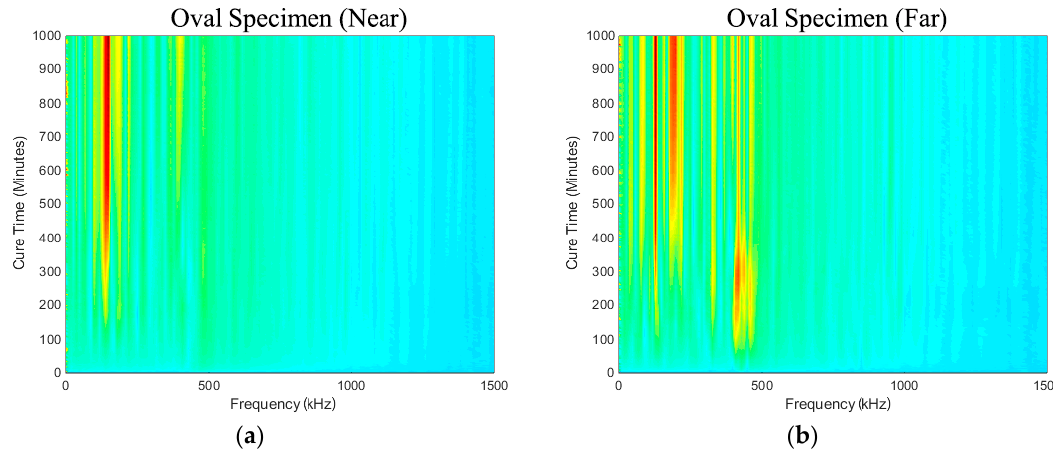
Figure 8. Oval specimens ( a ) Near and ( b ) Far: Change in frequency spectrum for each cure time relative to the baseline.